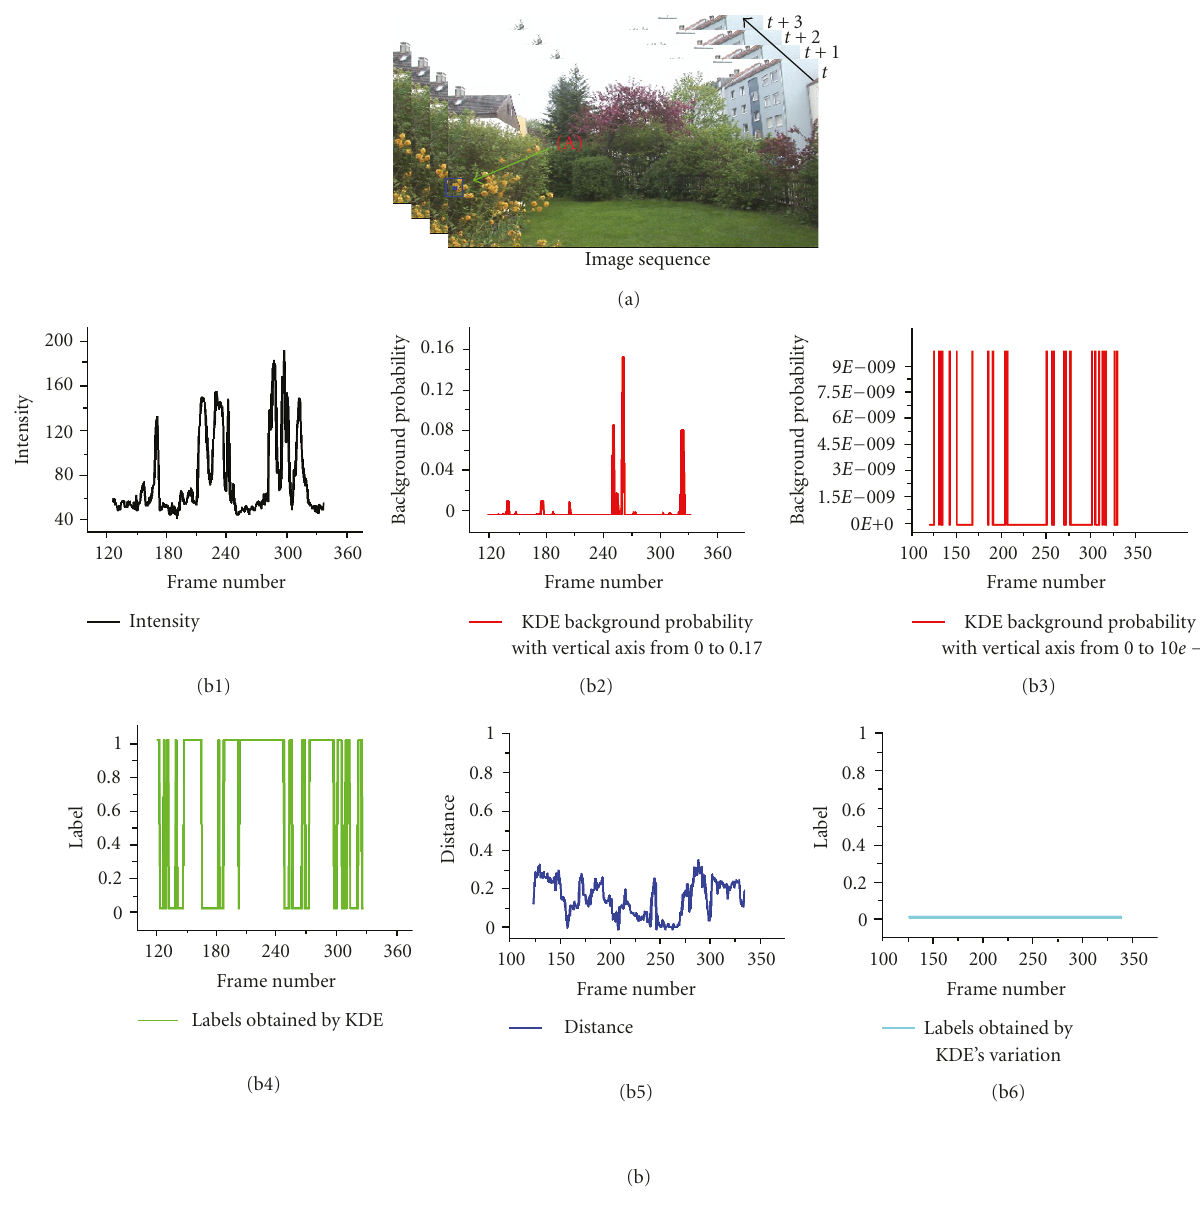
Figure 4: Evolving curves of the intensity values, background probabilities obtained by KDE, initial figure/ground labels obtained by KDE, the distances between the current local histogram of figure/ground segmentations and the corresponding background histogram, and the final labels obtained by KDE’s variation for a dynamic pixel A. (a) Outdoor scene with blue rectangle showing the location of the sample pixel A. (b) The corresponding curves mentioned above, for the dynamic pixel A,